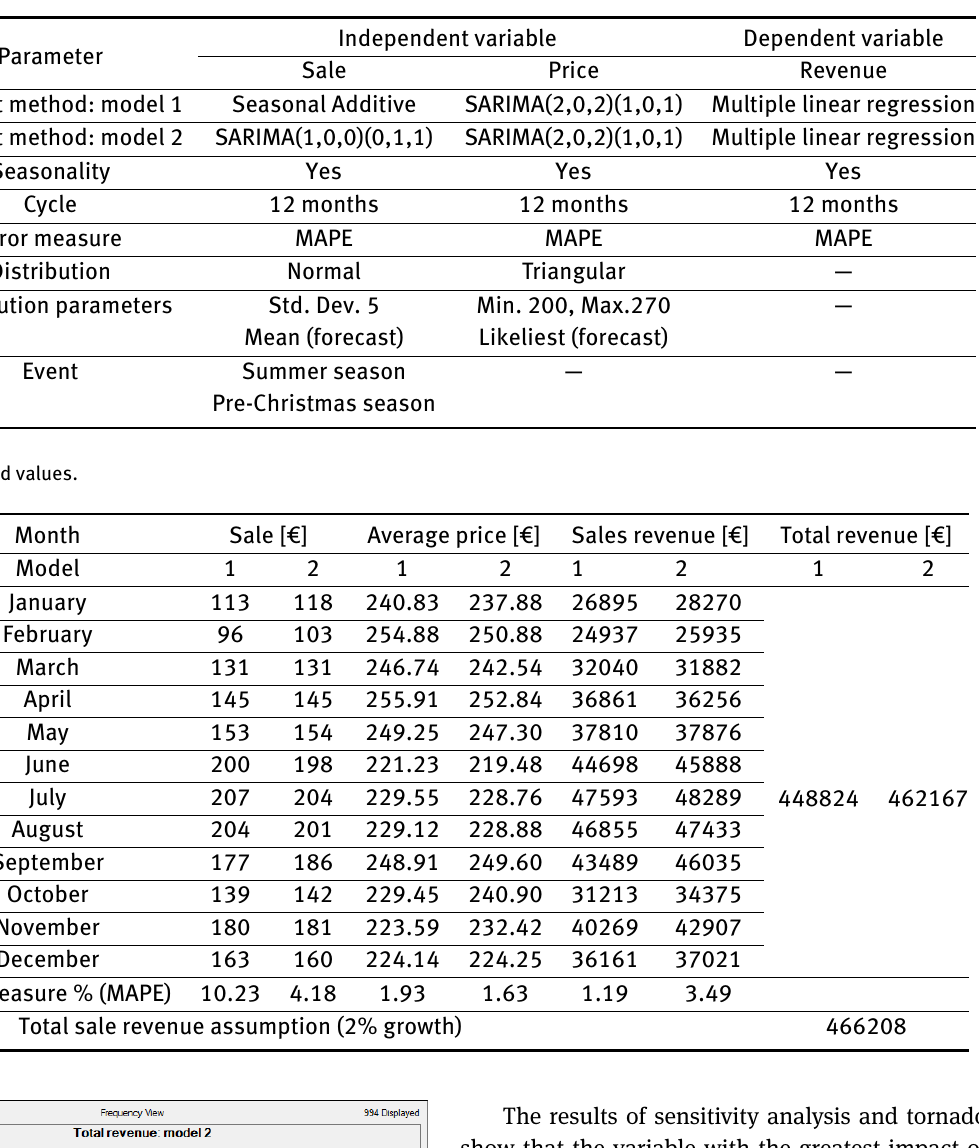
The results of sensitivity analysis and tornado chart show that the variable with the greatest impact on total revenue in both models is sold volume in July, August and June (Figure 9 and 10). These are months with the largest quantity sold. But sensitive analysis for model 1 shows that price assumption in particular months, espe- cially in March, August and April, has the strongest im- pact on the target forecast variable. In model 2, where sale in some seasons has significant impact on the final fore- casted value, the most important variable is sale assump- tion (Figure